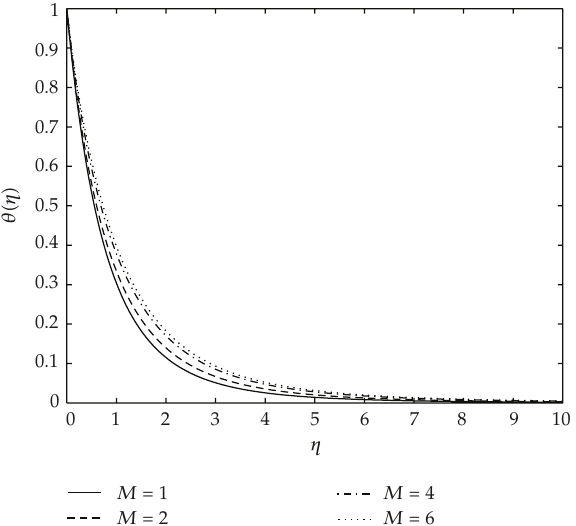
Figure 12: Temperature profiles for various values of M with S (cid:5) 1, Pr (cid:5) 0 . 72, m (cid:5) 1, β 2 (cid:5) 0 . 1, and β 1 (cid:5) 0 . 1